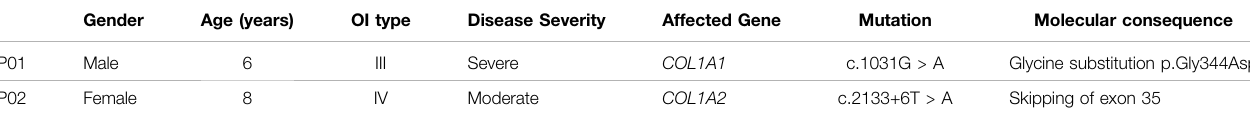
TABLE 1 | Characteristics of TERCELOI pediatric